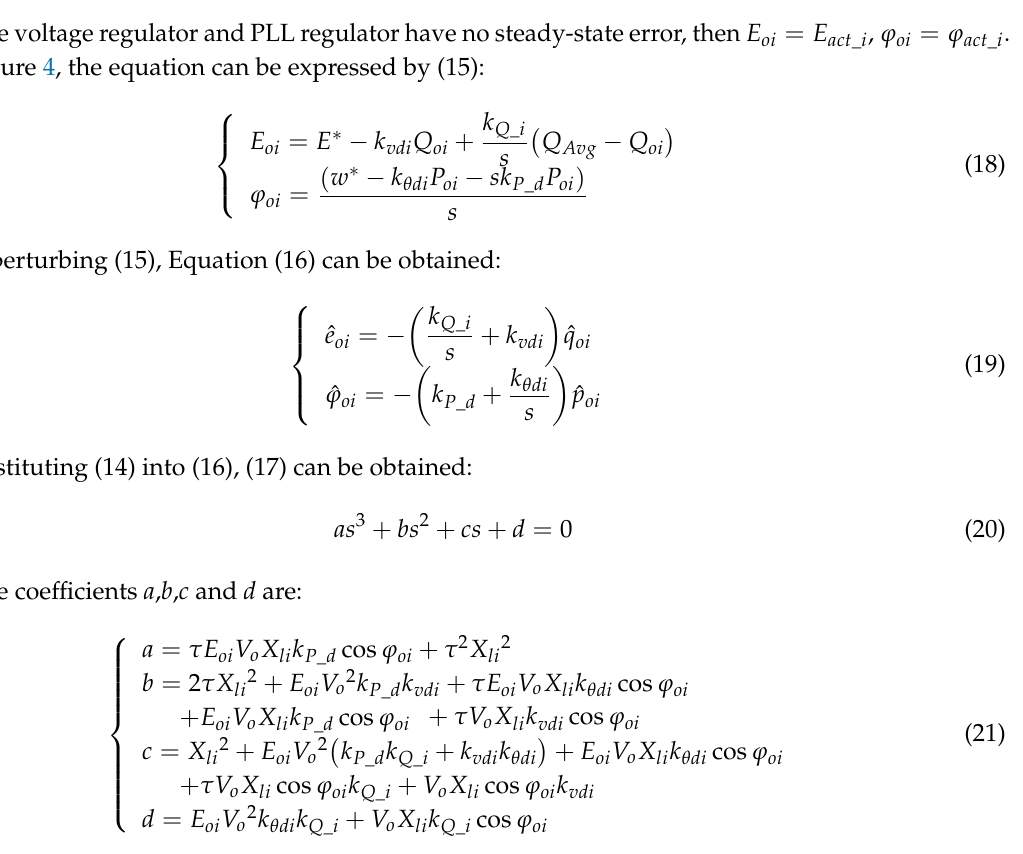
Figure 4. Detailed block diagram of droop control method with compensation controller.